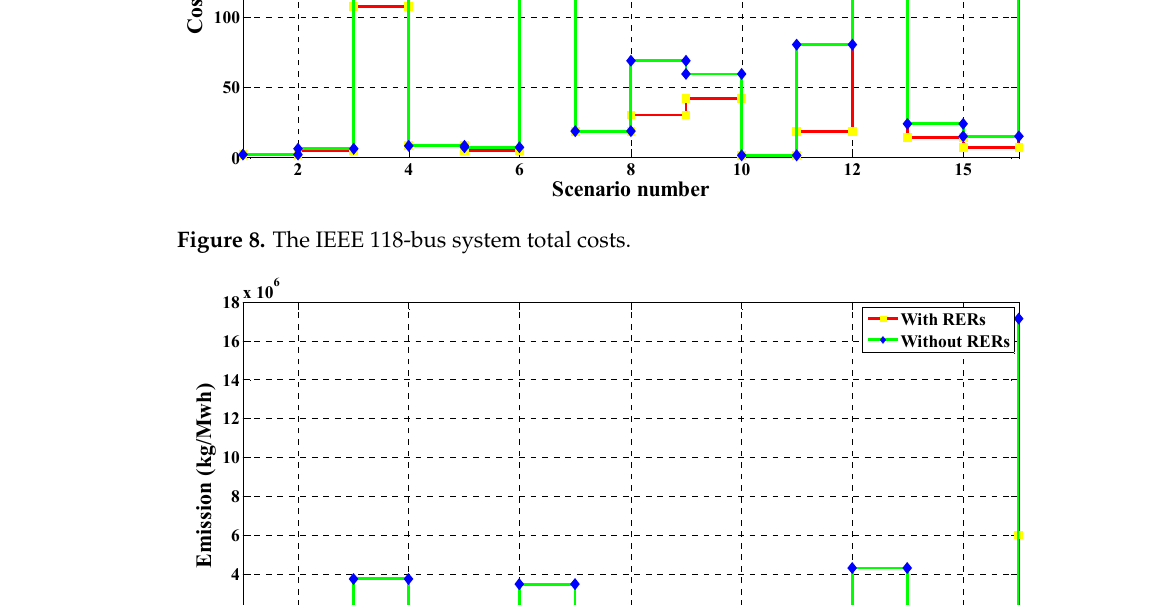
Figure 10. The IEEE 118-bus system VDs.